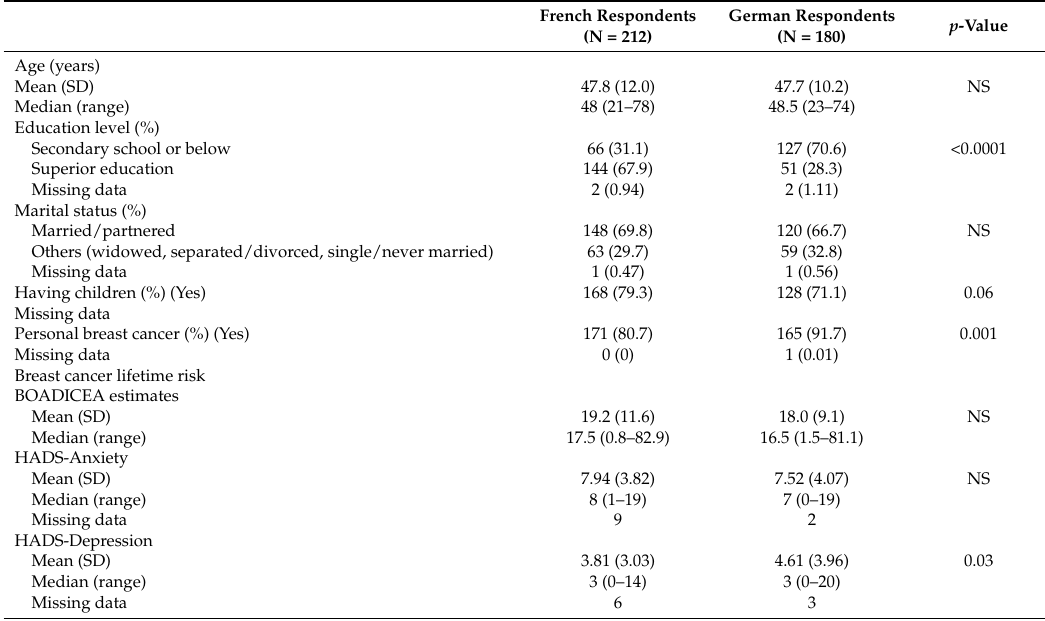
Table 1. Sociodemographic and clinical characteristics of the two